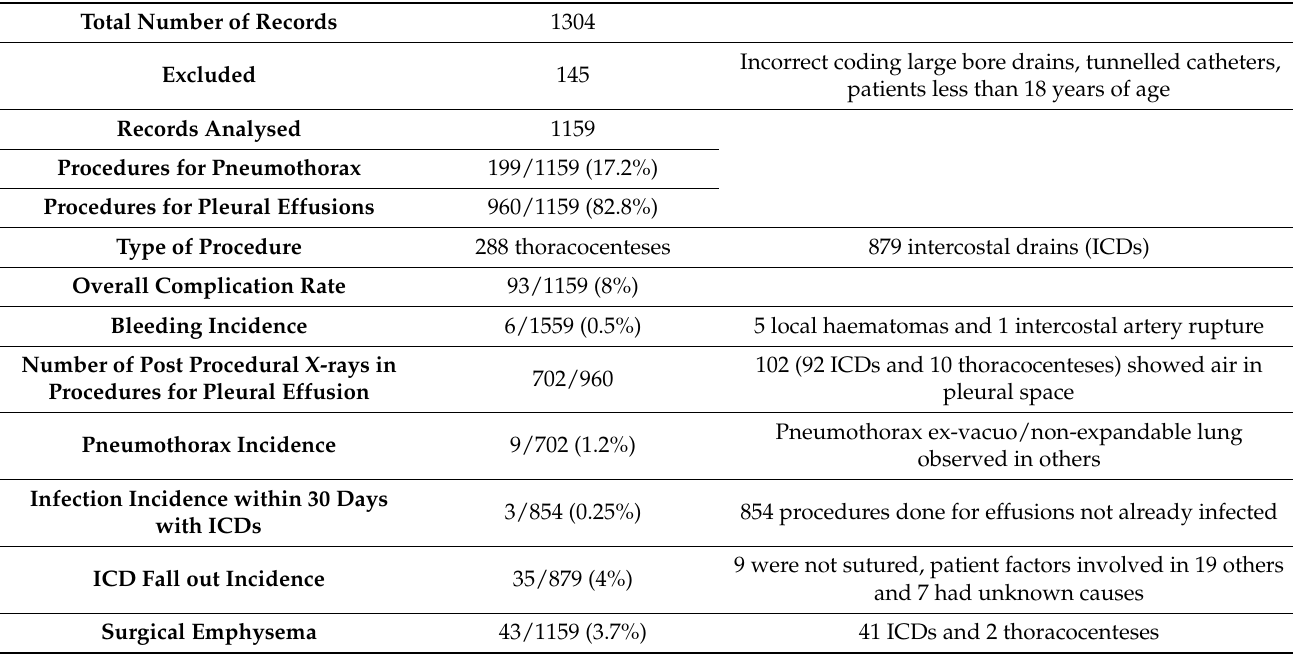
Table 1. Summary of records analysed and complication